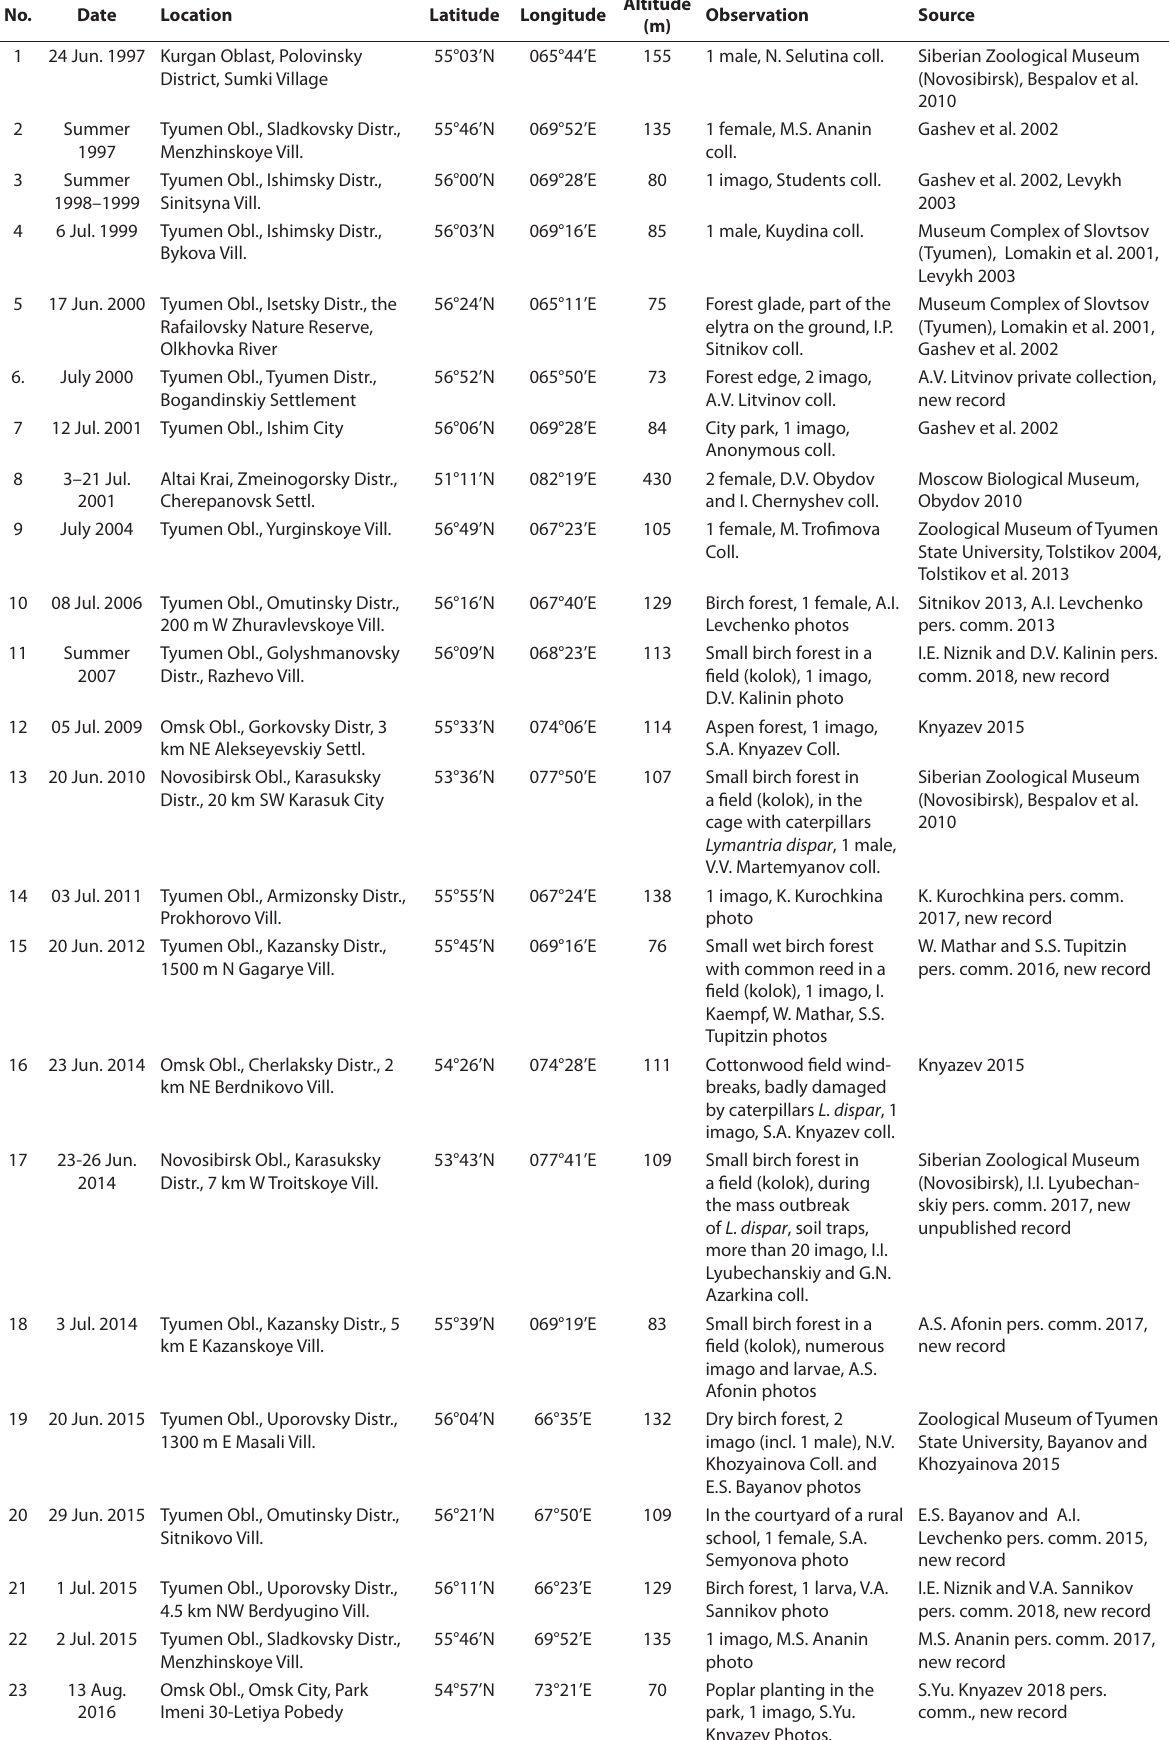
Table 1. Summary of the records of Calosoma sycophanta (L., 1758) in Western Siberia, Russia, 1997–2017. Datum for geographic coordinates: